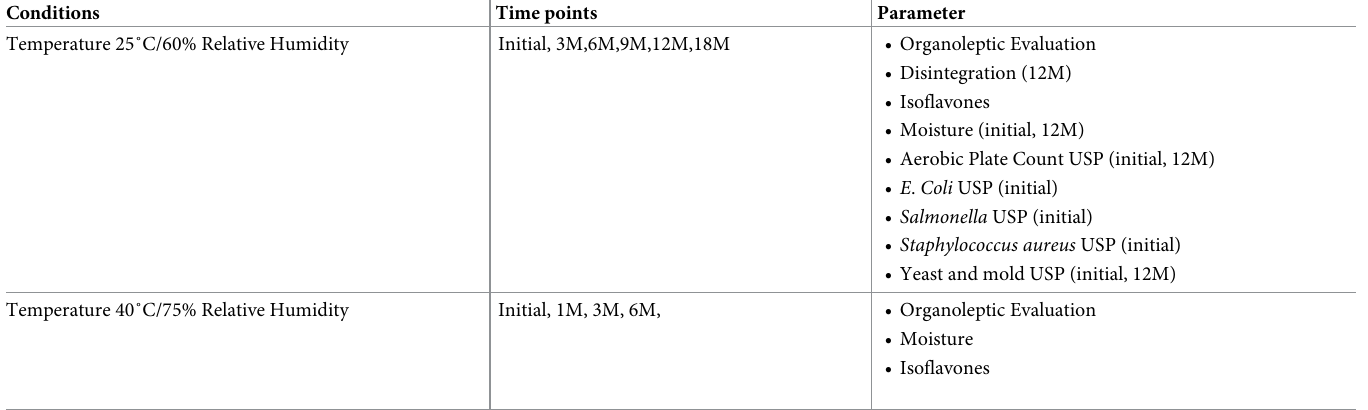
Table 4. Summary of the stability testing of Genistein capsules prepared and formulated in R.G.C.C.’s facilities.